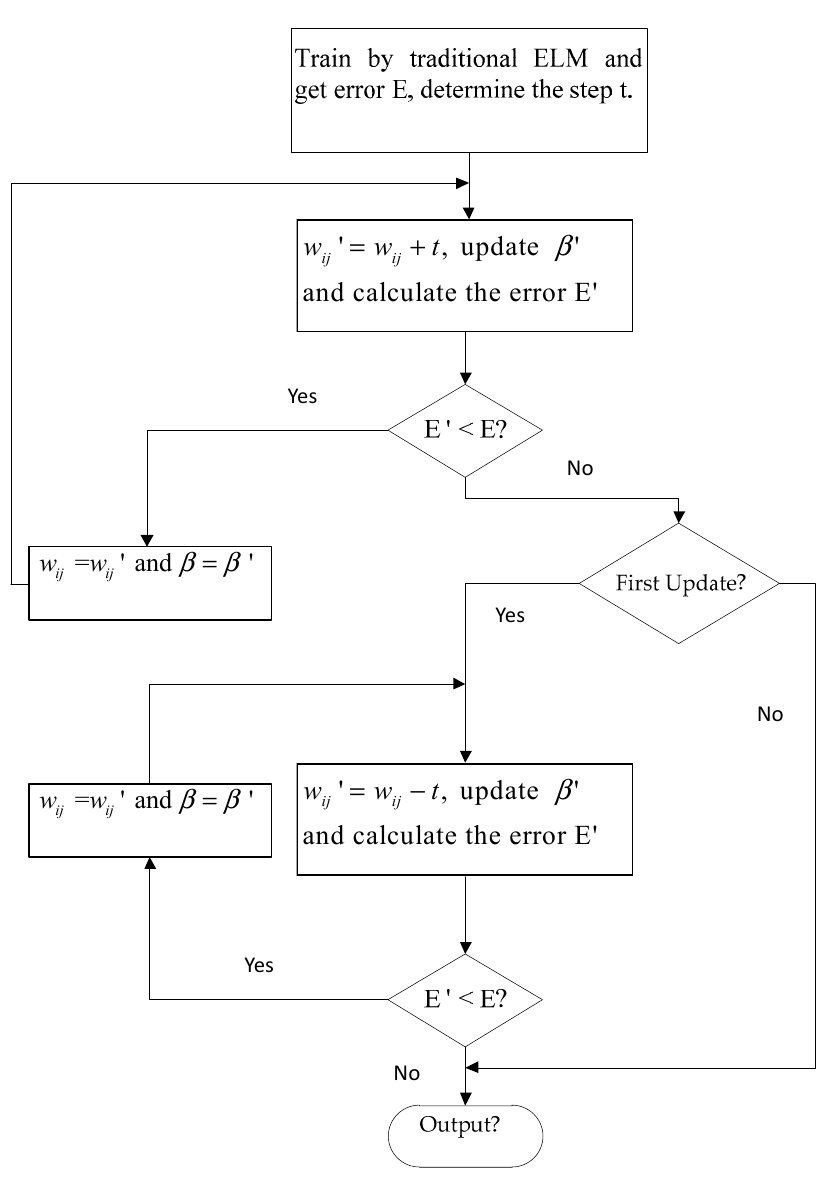
Figure 2. Computational process of improved ELM algorithm.